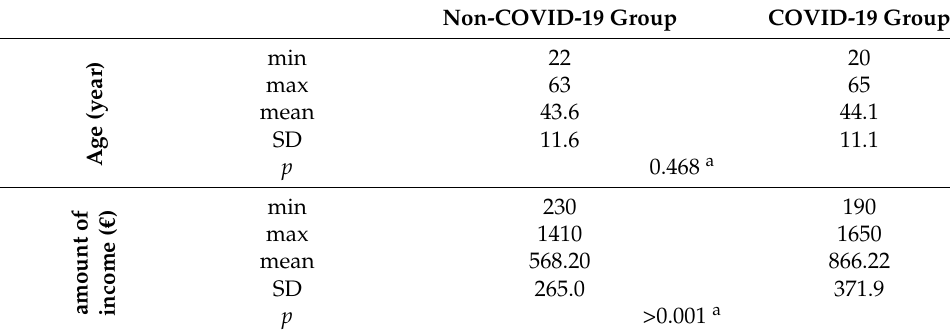
Table 1. Age distribution and amount of income in two observed